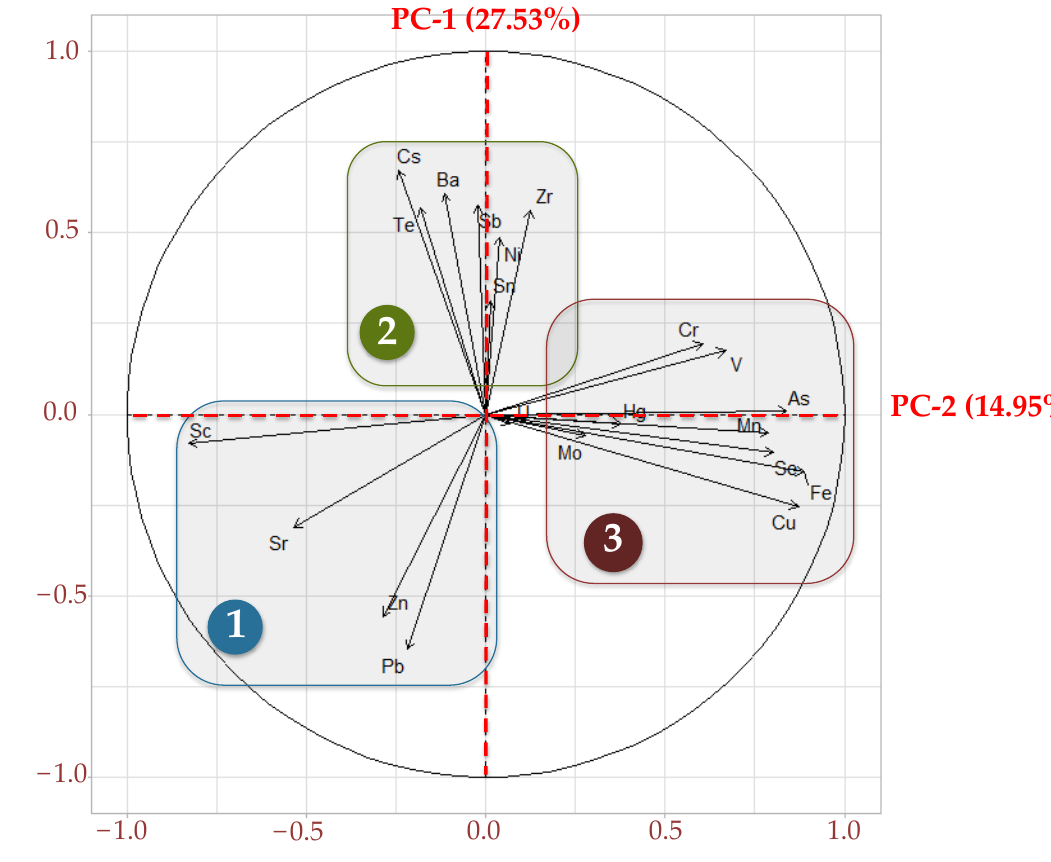
Figure 4. Principal component analysis revealing principal trace metallic sources.